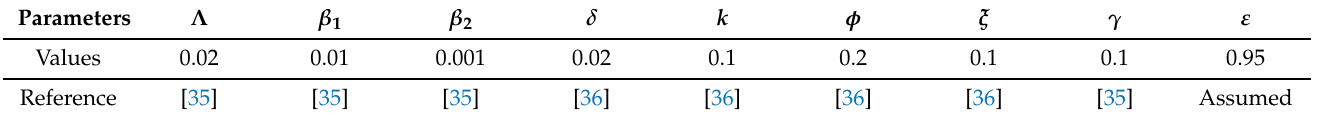
Table 3. Parameter values used in system (3) when E 0 = ( 1,0,0,0 ) and R 0 =